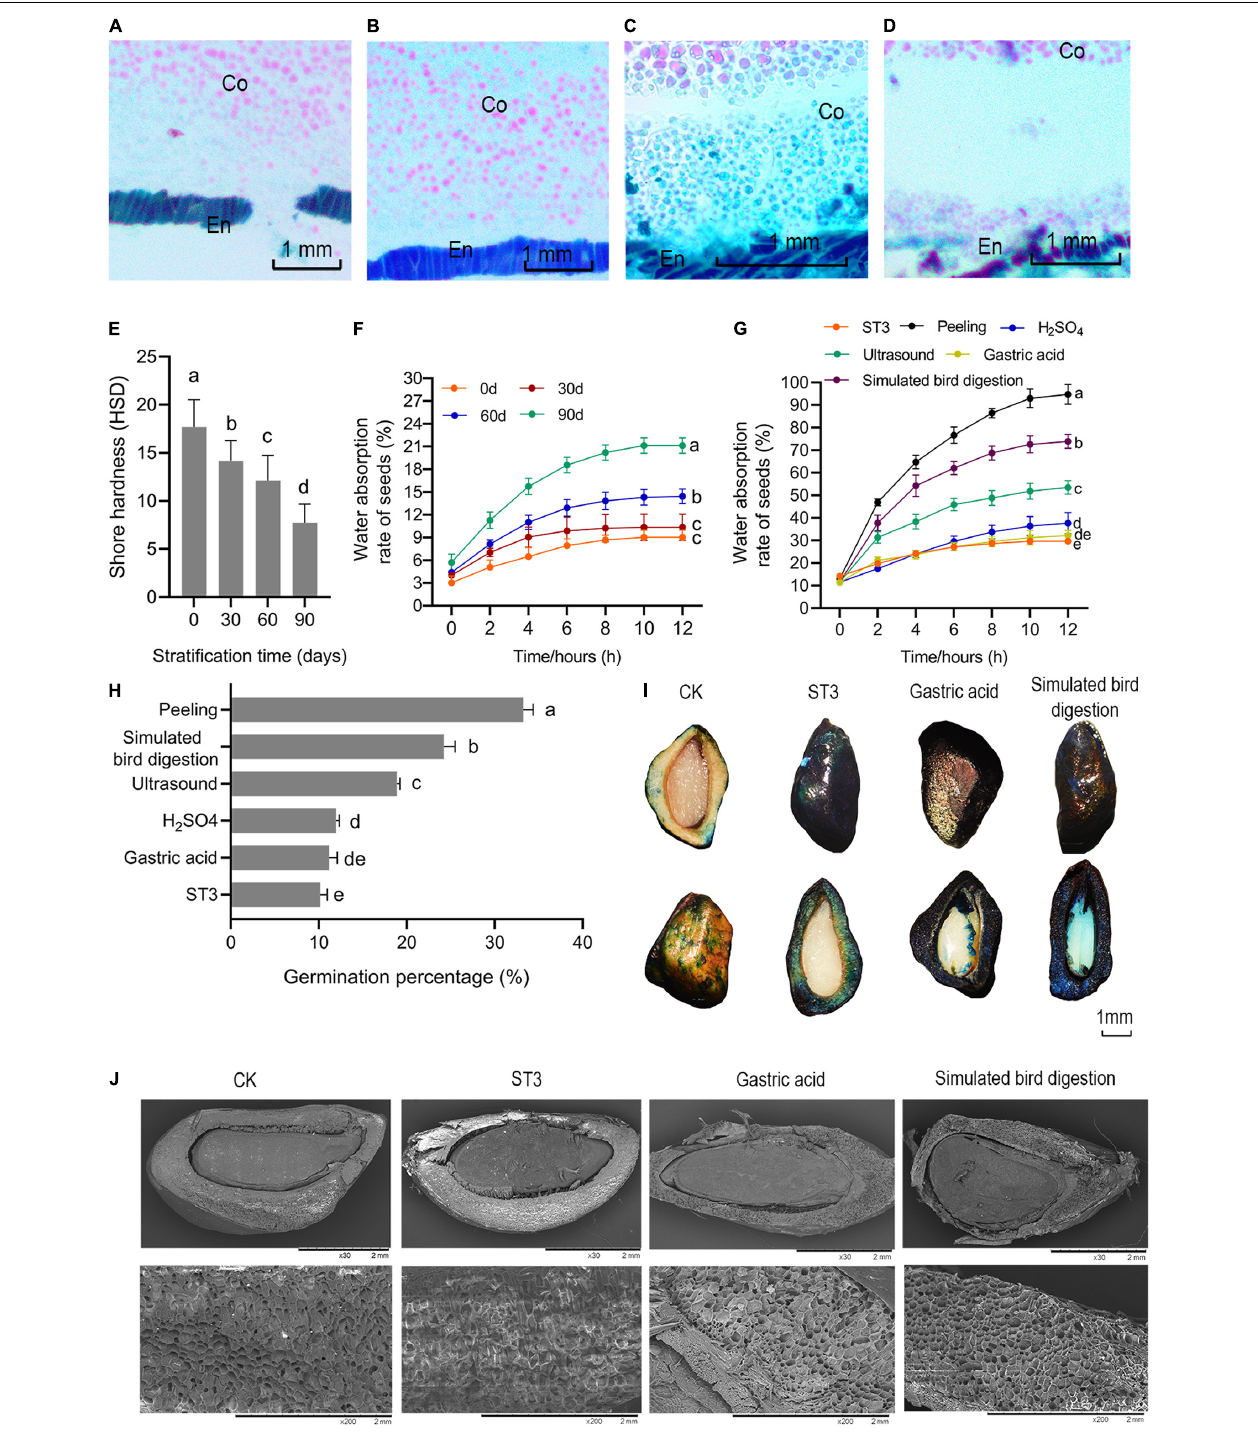
FIGURE 4 | Releasing constraint by the endocarp on embryos promoted Rosa rugosa seed germination. Distance between endocarp and embryo increased gradually as stratification increased from 0 day (A) to 30 (B) , 60 (C) , and 90 days (D) in the ST3 treatment. (E) Seed hardness gradually decreased with the increase of stratification time. (F) Seed water absorption rate remained stable at 12 h in all treatments, and seeds with 90 days of stratification had the highest absorption. Seeds were treated with gastric acid, 98% H 2 SO 4 , simulated bird digestion, or peeling after ST3 treatment, and peeled seeds had the highest water absorption capacity (G) and germination percentage (H) followed by simulated bird digestion, which caused maximum penetration among chemical treatments with the largest area dyed blue (I) and maximum endocarp damage (J) . En, endocarp; Co, cotyledon.